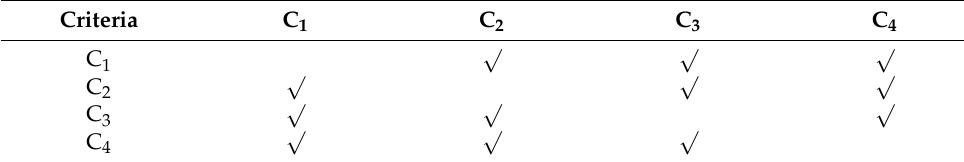
Table 2. Dependences among decision criteria for wind farm site selection.